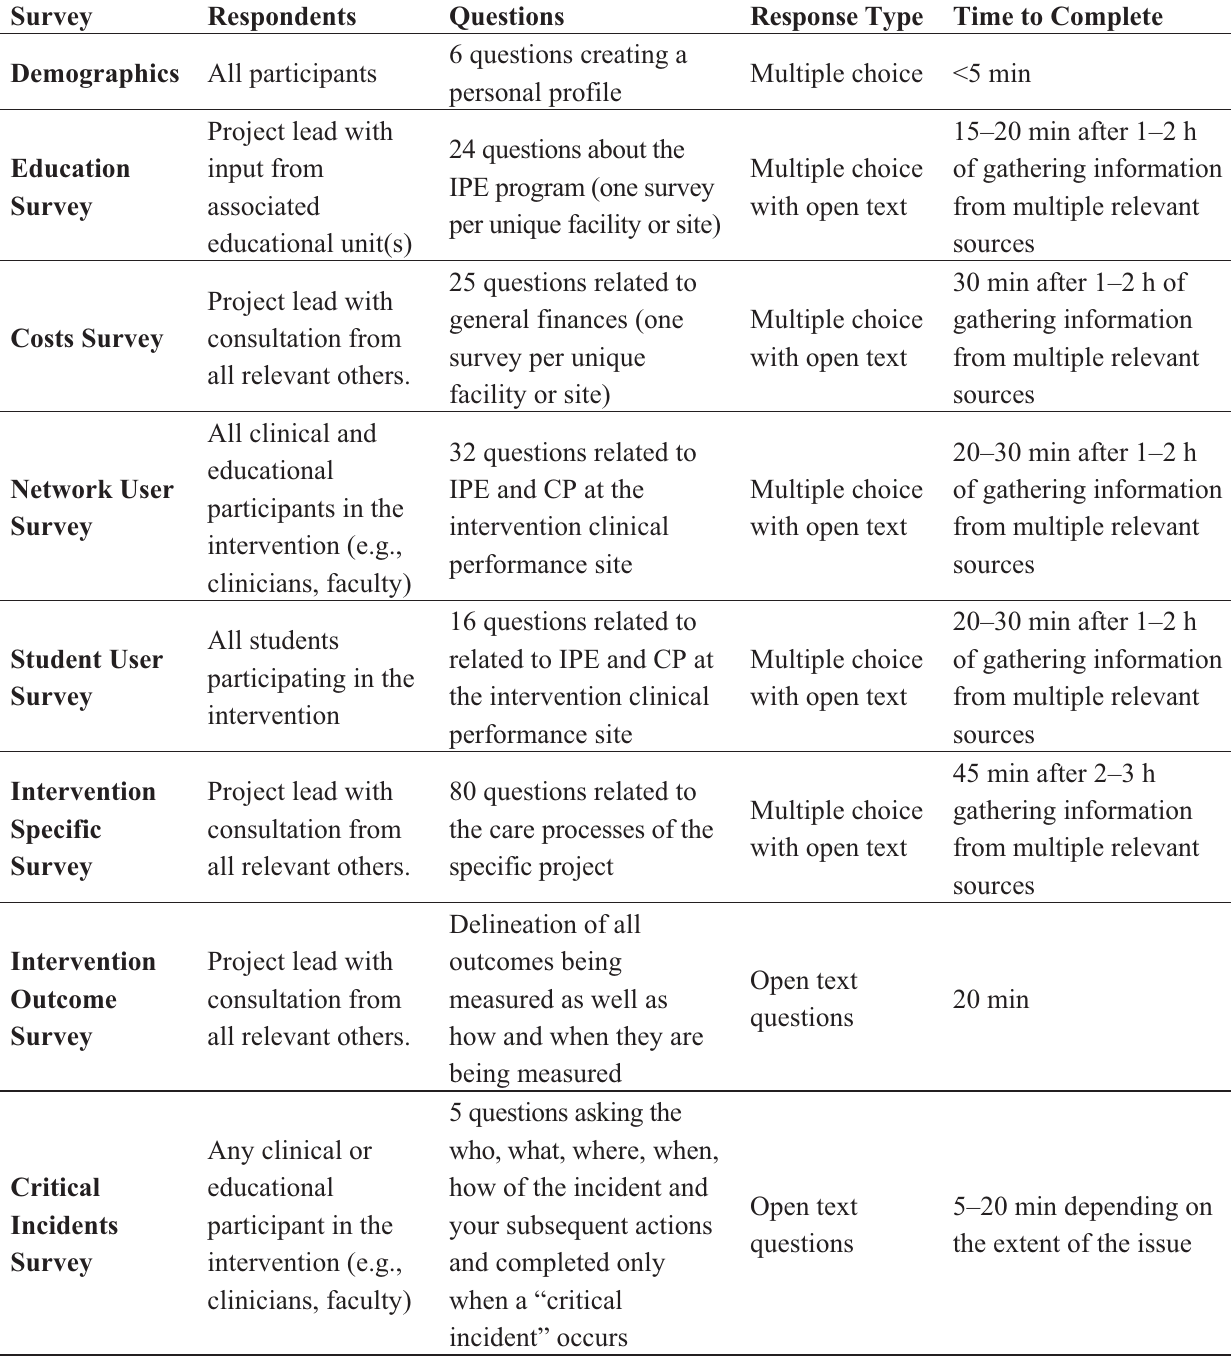
Table 2. National center data repository